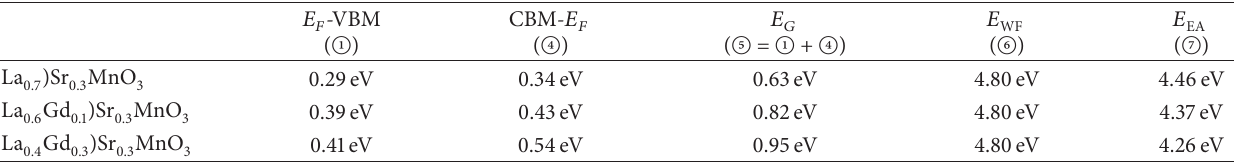
Gd )Sr MnO films. 0.4 0.3 0.3 3